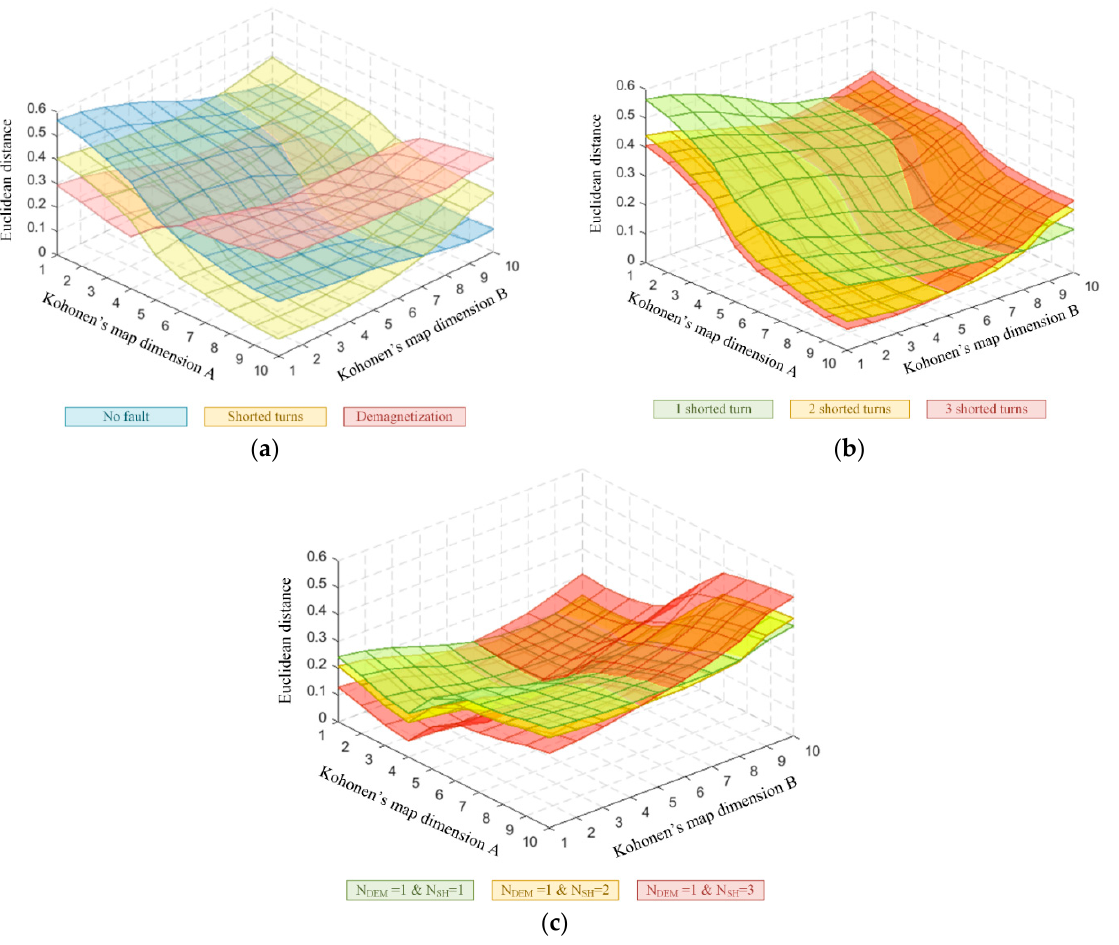
Figure 6. Experimental verification of the SOM-based fault detector of the PMSM motor: ( a ) fault classification — SOM response for training data; ( b ) assessment of stator damage degree — SOM response for training data; ( c ) simultaneous fault of the PMSM stator and rotor — SOM response for training dataset: Nsh— number of shorted turns, Ndem— permanent magnet technical condition (0 — unfaulty, 1 — partial demagnetization).